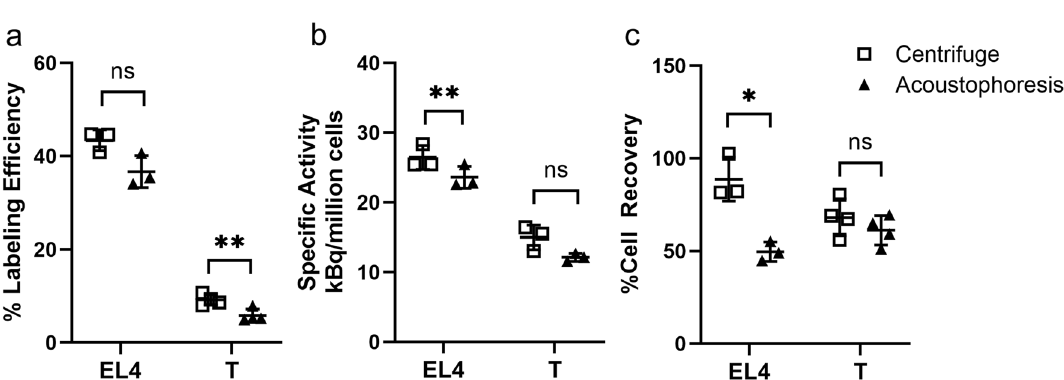
Figure 4. ( a ) Labeling efficiency (the incorporated activity compared to the incubated activity). ( b ) Labeled specific activity (kBq/million cells). ( c ) Cell recovery using centrifugal and acoustophoresis labeling methods. N = 3 for all EL4 cell tests. N = 3 for T cell specific activity and N = 4 for labeling efficiency and cell recovery tests. * P < 0.05, ** P < 0.01, ns: not significant. Plots show mean ± SD for each set of N